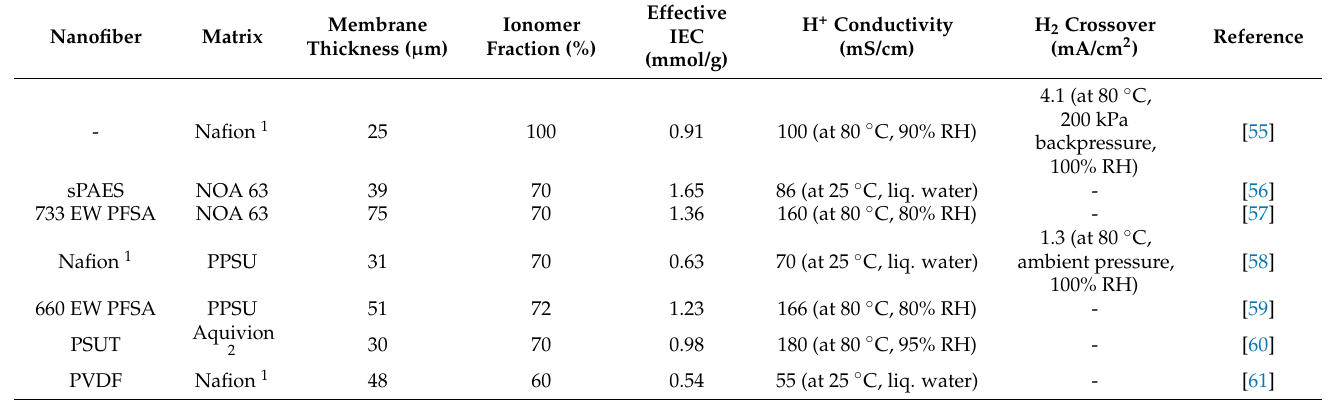
Table 2. Summary of electrospun PEMs and their